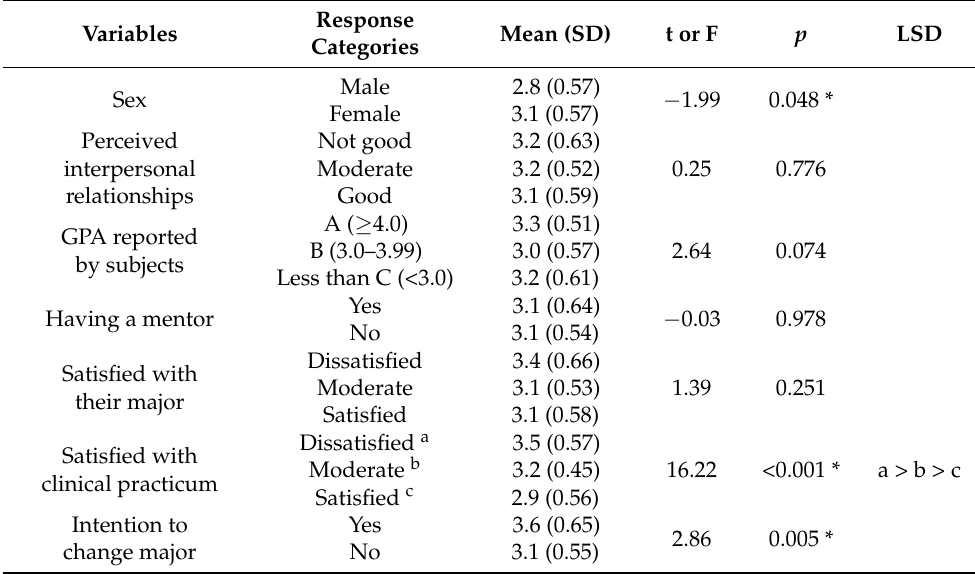
Table 3. Stress related to clinical practicum according to general characteristics ( n =